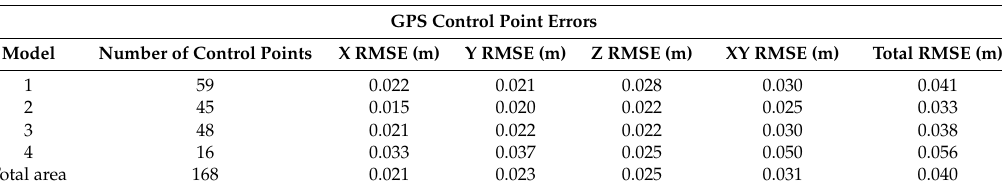
Table 2. Root-mean-square discrepancies between the coordinates of the GPS control points and their calculated position in the Photoscan models.